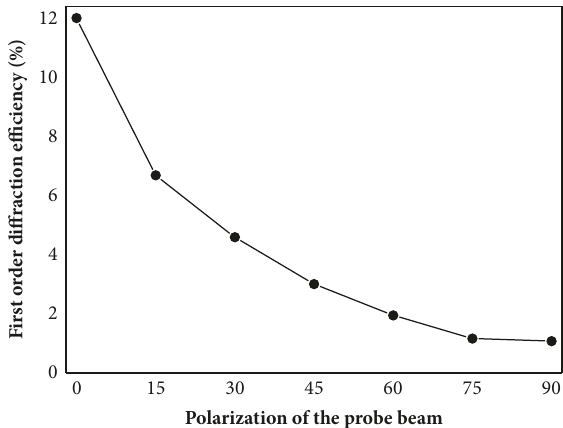
Figure 4: The diffraction efficiency of the first-order beams versus polarization of the probe beam with applied voltage ∼